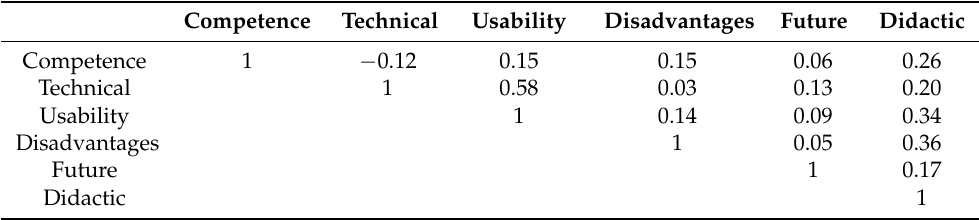
Table 3. Pearson correlation coefficients of the responses to the different factors of the questionnaire (270